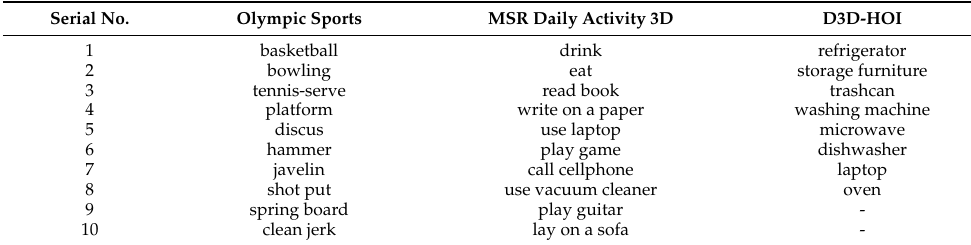
Table 1. Human–object interactions included in all three datasets. Serial